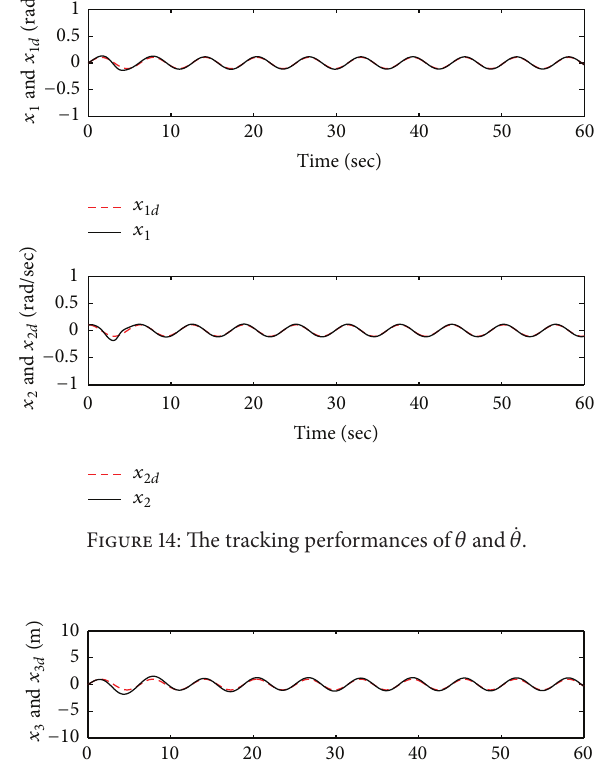
Figure 14: The tracking performances of 𝜃 and